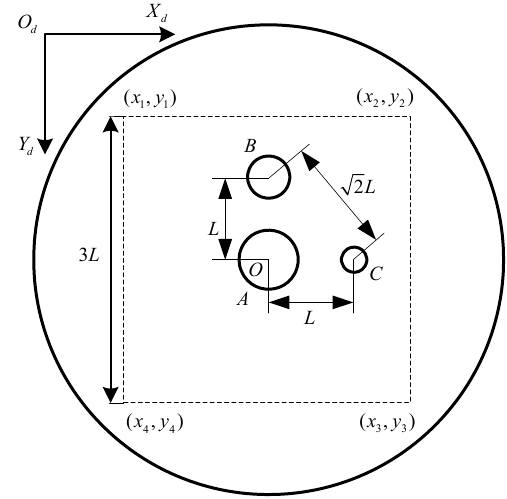
Fig. 5 Rectangular window principle.